Question: What style of plot is this figure drawn as?
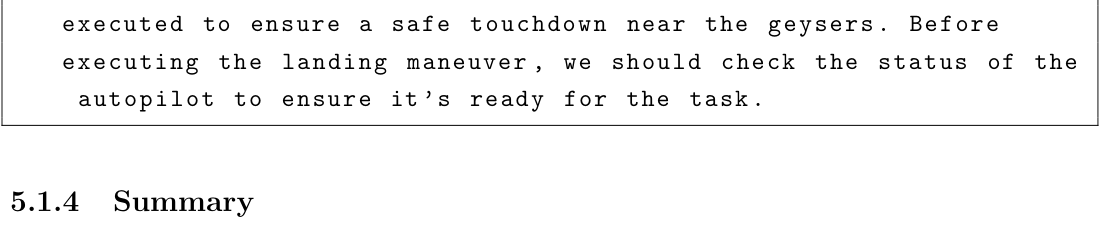
Answer: line